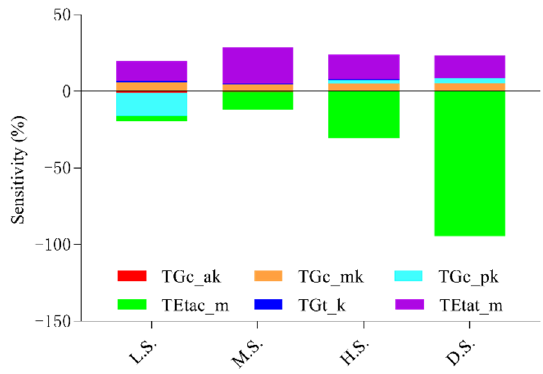
Figure 5. Sensitivity analysis for tuning factors.